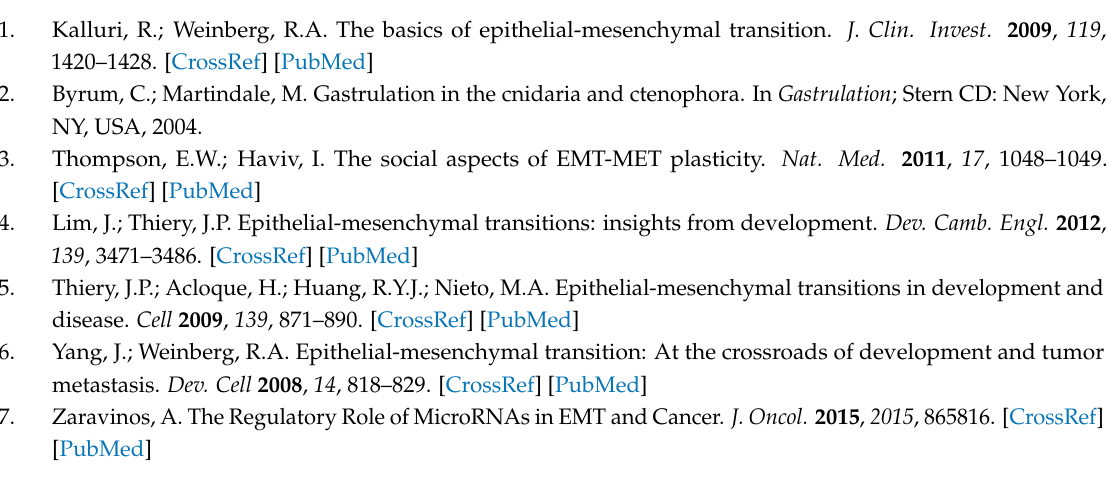
Table S1: MicroRNA signatures in NSCLC